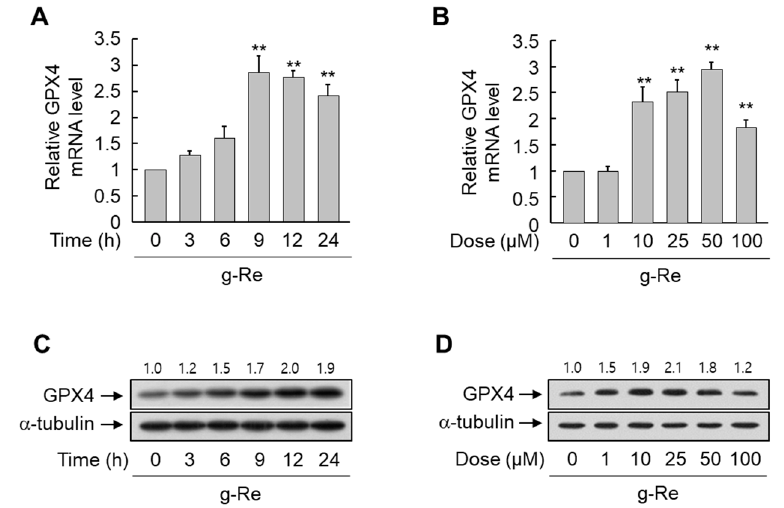
Figure 5. E ff ects of ginsenoside Re (g-Re) on the expression of glutathione peroxidase 4 (GPX4) in Figure 5. Effects of ginsenoside Re (g-Re) on the expression of glutathione peroxidase 4 (GPX4) in SH- SH-SY5Y cells. ( A and C ) Cells were exposed to 25 µ M g-Re for the indicated durations. ( B , D ) Cells Figure 5. Effects of ginsenoside Re (g-Re) on the expression of glutathione peroxidase 4 (GPX4) in SH- SY5Y cells. ( A and C ) Cells were exposed to 25 µM g-Re for the indicated durations. ( B , D ) Cells were Figure 5. Effects of ginsenoside Re (g-Re) on the expression of glutathione peroxidase 4 (GPX4) in SH- were treated with the indicated concentrations of g-Re for 9 h ( B ) and 24 h ( D ). The mRNA and protein SY5Y cells. ( A and C ) Cells were exposed to 25 µM g-Re for the indicated durations. ( B , D ) Cells were treated with the indicated concentrations of g-Re for 9 h ( B ) and 24 h ( D ). The mRNA and protein SY5Y cells. ( A and C ) Cells were exposed to 25 µM g-Re for the indicated durations. ( B , D ) Cells were levels of GPX4 were analyzed by real-time PCR ( A , B ) and immunoblotting ( C , D ), respectively. Results treated with the indicated concentrations of g-Re for 9 h ( B ) and 24 h ( D ). The mRNA and protein levels of GPX4 were analyzed by real-time PCR ( A , B ) and immunoblotting ( C , D ), respectively. treated with the indicated concentrations of g-Re for 9 h ( B ) and 24 h ( D ). The mRNA and protein are expressed as mean ± SE (n = 3). RPS18 and α -tubulin were used as internal controls for real-time levels of GPX4 were analyzed by real-time PCR ( A , B ) and immunoblotting ( C , D ), respectively. Results are expressed as mean ± SE (n = 3). RPS18 and α -tubulin were used as internal controls for levels of GPX4 were analyzed by real-time PCR ( A , B ) and immunoblotting ( C , D ), respectively. PCR and immunoblotting, respectively. ** p < 0.01 compared with the untreated Results are expressed as mean ± SE (n = 3). RPS18 and α -tubulin were used as internal controls for real-time PCR and immunoblotting, respectively. ** p < 0.01 compared with the untreated group. Results are expressed as mean ± SE (n = 3). RPS18 and α -tubulin were used as internal controls for real-time PCR and immunoblotting, respectively. ** p < 0.01 compared with the untreated group. real-time PCR and immunoblotting, respectively. ** p < 0.01 compared with the untreated group.